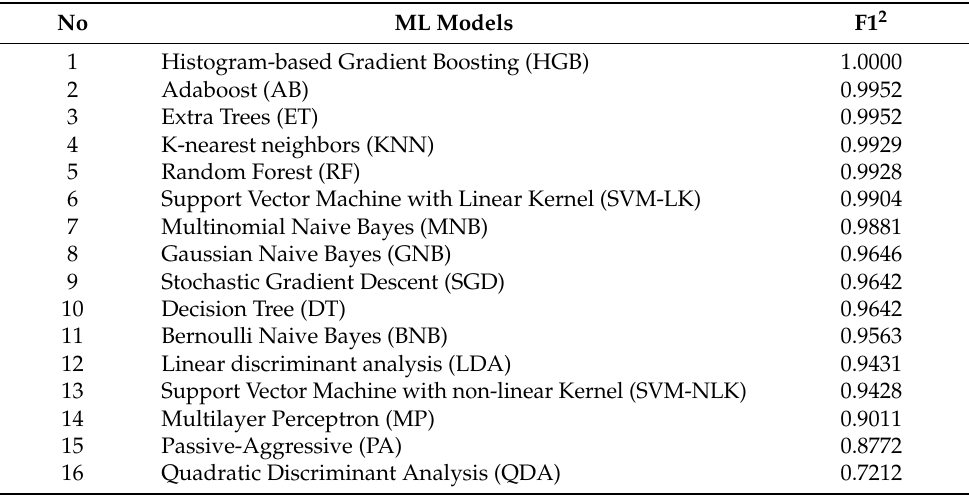
Figure 3. Performance of ML models in classifying surviving and non-surviving COVID-19 patients, using the 34 features. Table 4. Classification performance of ML models run with 34 features to detect patient